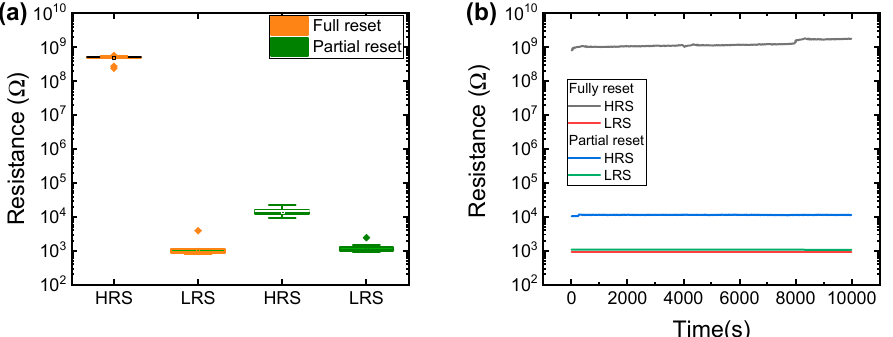
Figure 3. ( a ) HRS and LRS resistance distribution and ( b ) retention for full reset mode and partial reset mode for 10000 s.